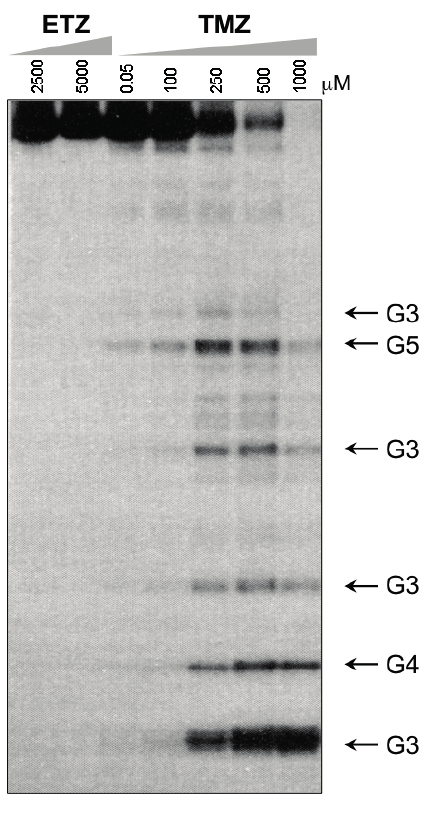
Figure 3. Comparison of reaction of ETZ and TMZ with DNA, showing the unreactivity of ETZ up to 5 mM, sites of G N 7 alkylation produced in the 276-bpBamHI-Sal1 fragment of pBR322, by the piperidine cleavage method. Adapted from reference